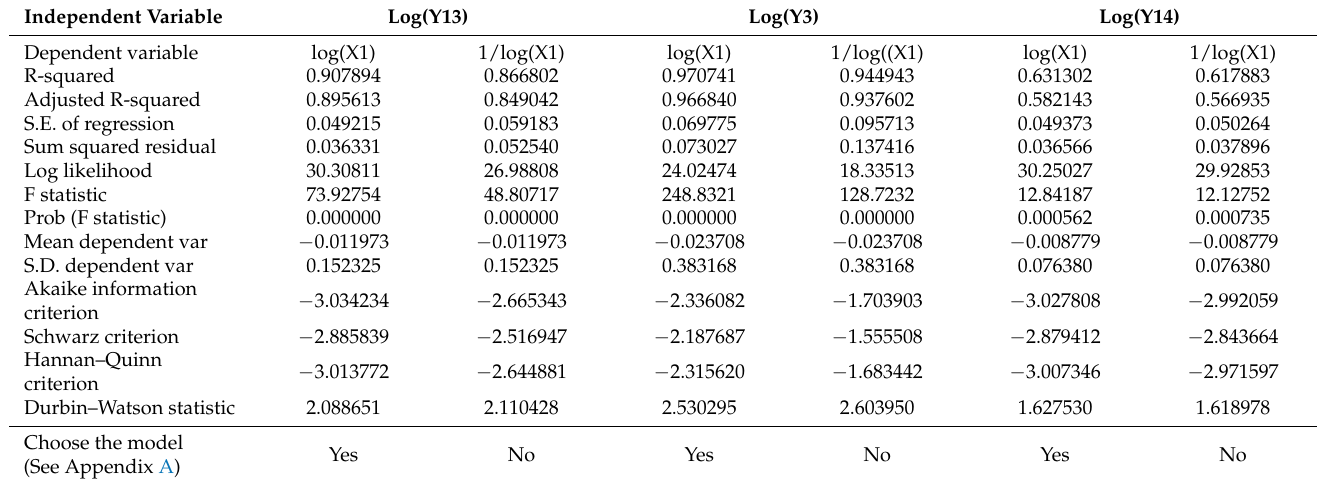
Table 4. Results of the regression (Test